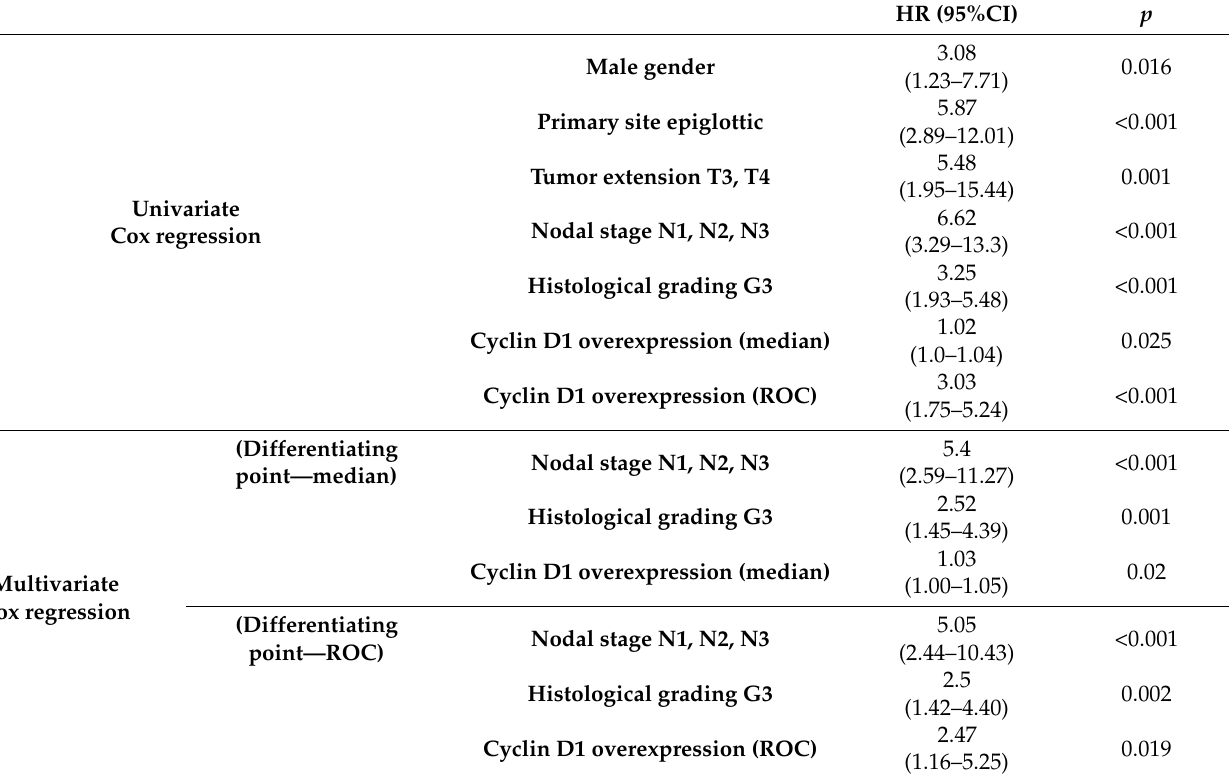
Table 5. Overall survival in laryngeal cancer (LC) patients (n = 101) in univariate and multivariate Cox regression analysis, differentiating point of Cyclin D1 expression group was median (chi 2 = 47.53; p < 0.0001) or cut-off point nominate in ROC curves analysis at the level of 15% (chi 2 = 48.29; p <